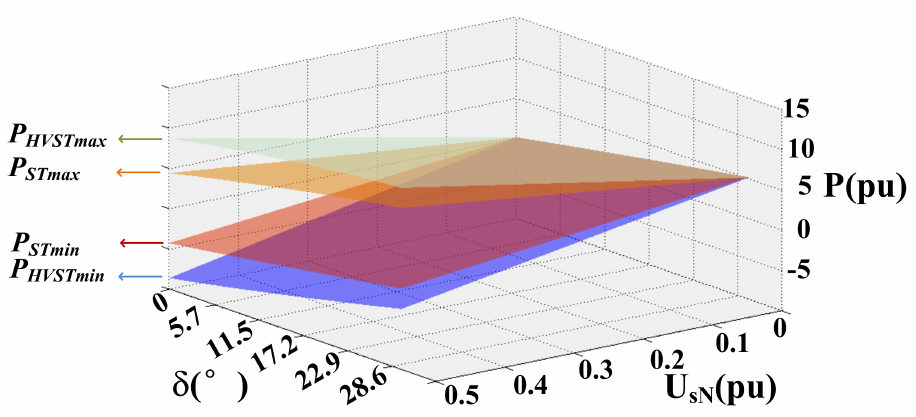
Figure 9. The active power flow regulatory region controlled by the ST and the HVST.